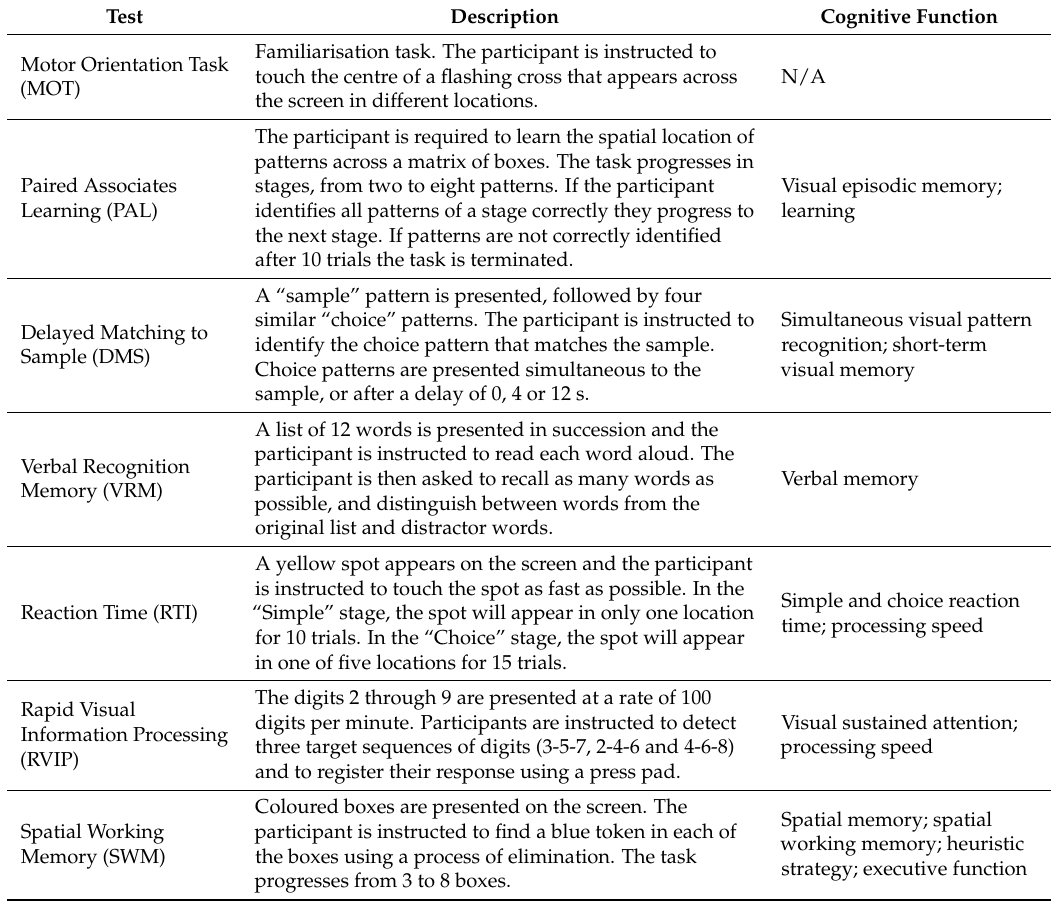
Table 1. Description of CANTAB tests and cognitive functions